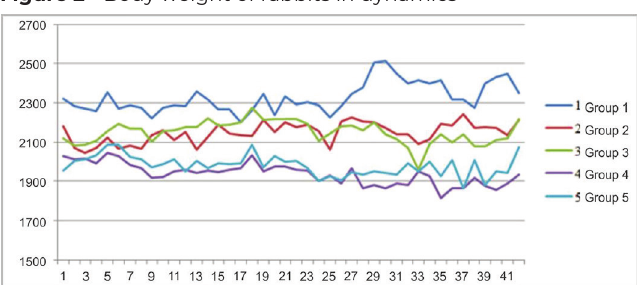
Figure 2 - Body weight of rabbits in dynamics